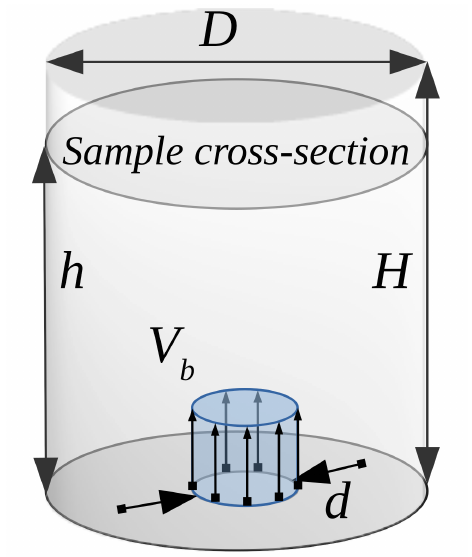
Figure 1. Schematics of a bubble column